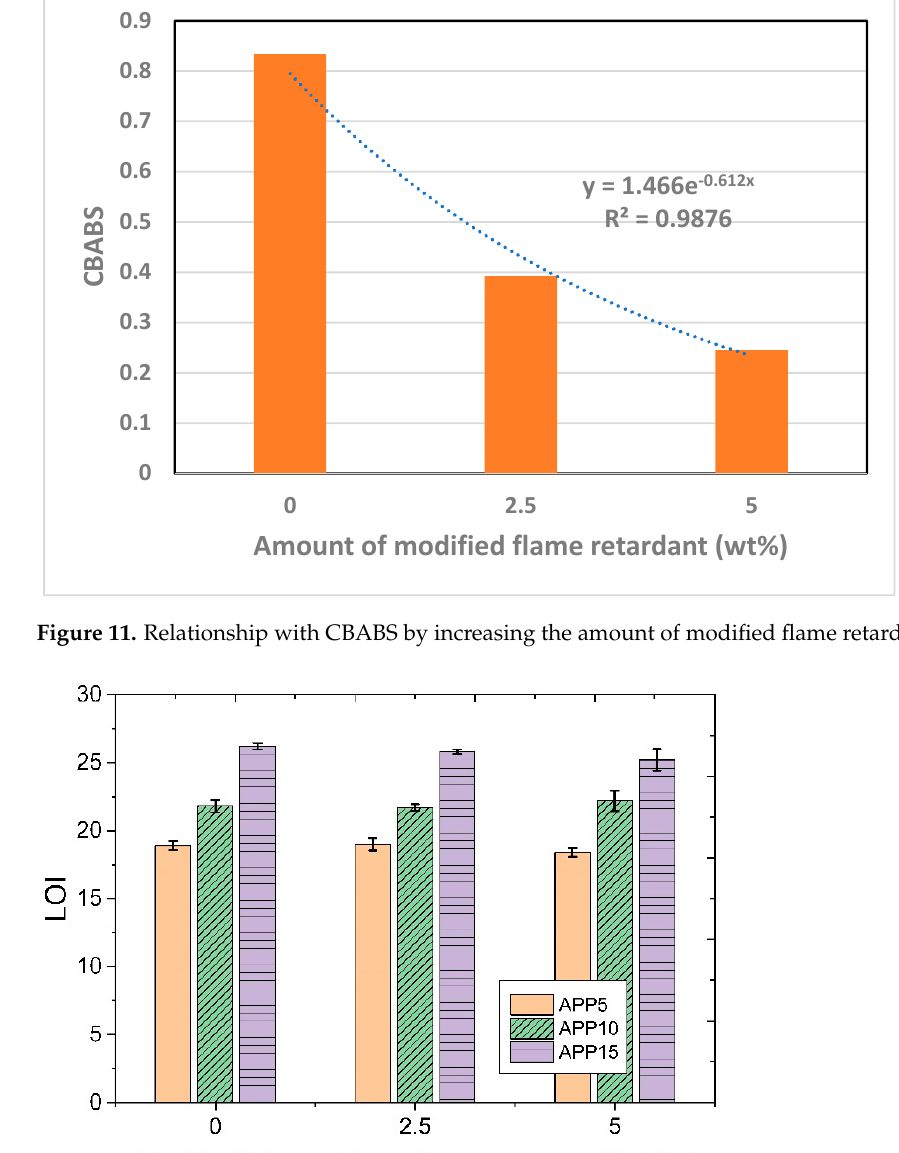
Figure 10. Relationship with CBATS as function of the increase in the amount of modified flame